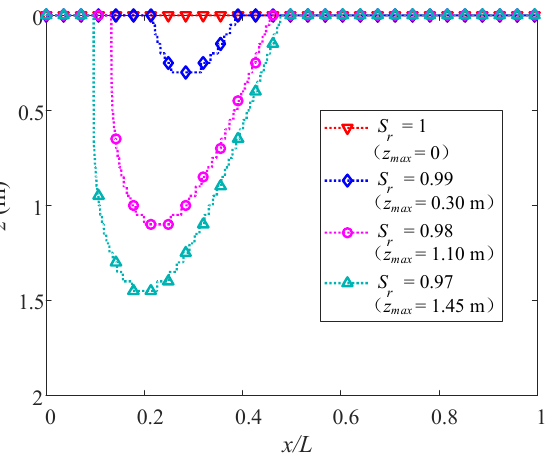
Figure 24. Distributions of maximum liquefaction depth with different degrees of saturation.